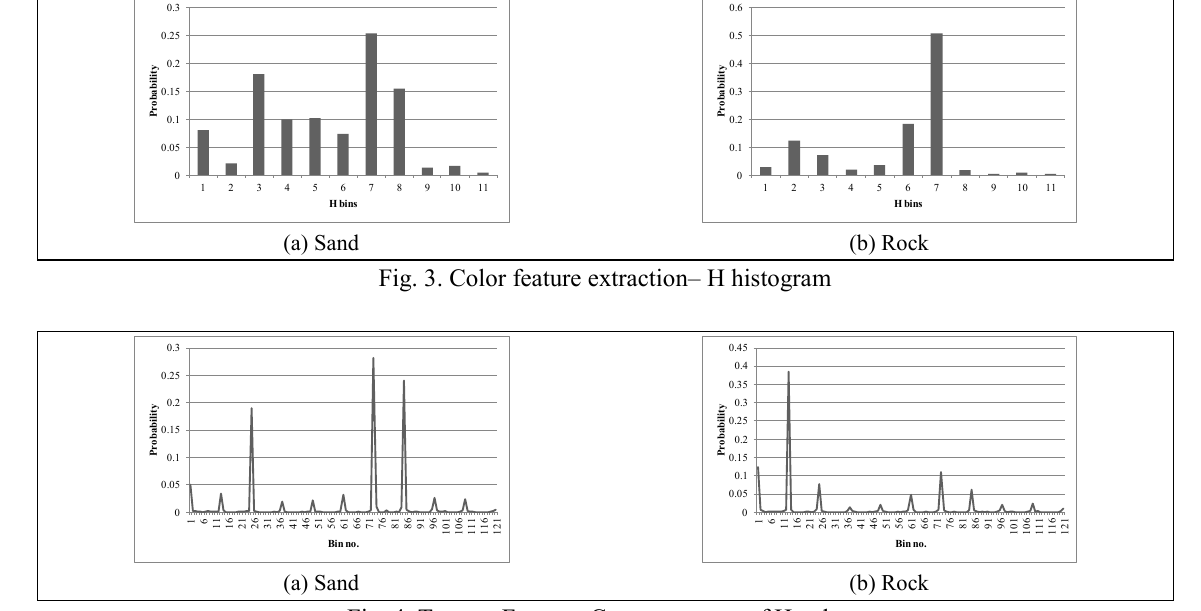
Fig. 4. Texture Feature: Co–occurrence of H